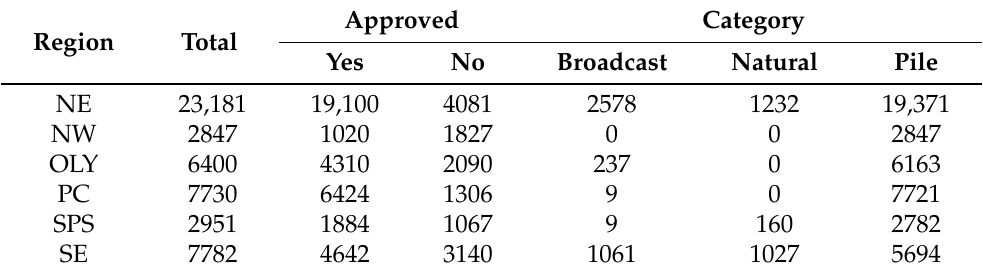
Table 2. Area and percent of DNR administrative regions (Northeast (NE), Northwest (NW), Olympic (OLY), Pacific Coast (PC), South Puget Sound (SPS), and Southeast (SE)). Total area and per- cent of Washington State that each DNR administrative region occupies are reported alongside the area and percent within the DNR administrative regions of each land ownership (public, private) and ecoregion category (Blue Mountains (BM), Cascades (C), Coast Range (CR), Columbia Plateau (CP), Eastern Cascades Slopes and Foothills (EC), North Cascades (NC), Northern Rockies (NR), Puget Lowland (PL), Willamette Valley (WV)). Areal measurements are in square kilometers. Ownership Ecoregion Region Total Public Private BM